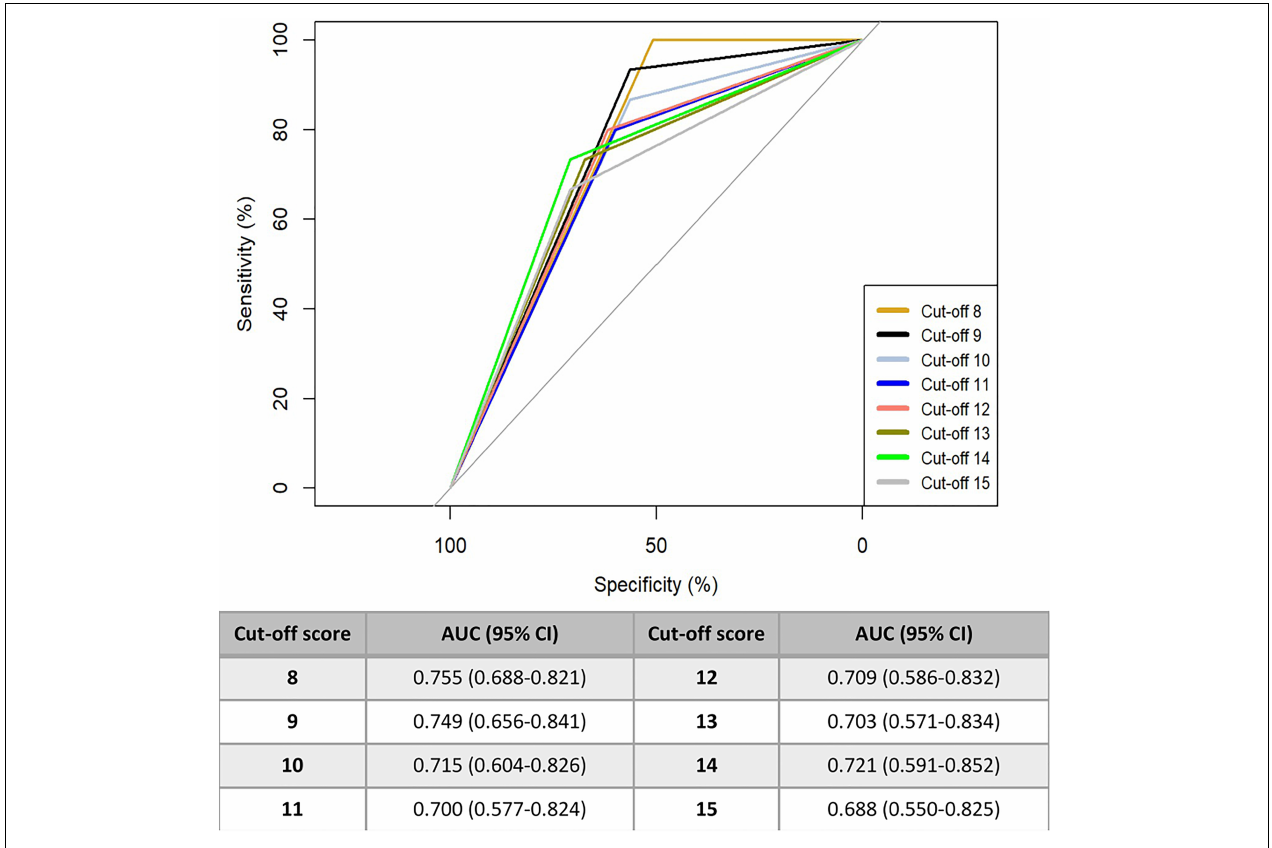
FIGURE 1 | AUC for ROC curves based on different cut-off scores of CAPD tool.